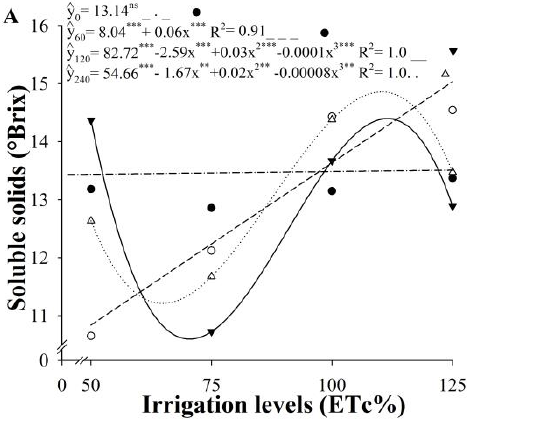
Figure 8. Soluble solids of fig fruits produced in the 2018/2019 ( A ) and 2019/2020 ( B ) production cycles as a function of irrigation levels and potassium doses under semiarid conditions in the 2018/2019 and 2019/2020 crop years. ** Significant ( p < 0.01); *** Significant ( p < 0.001); ns Not significant ( p > 0.05).